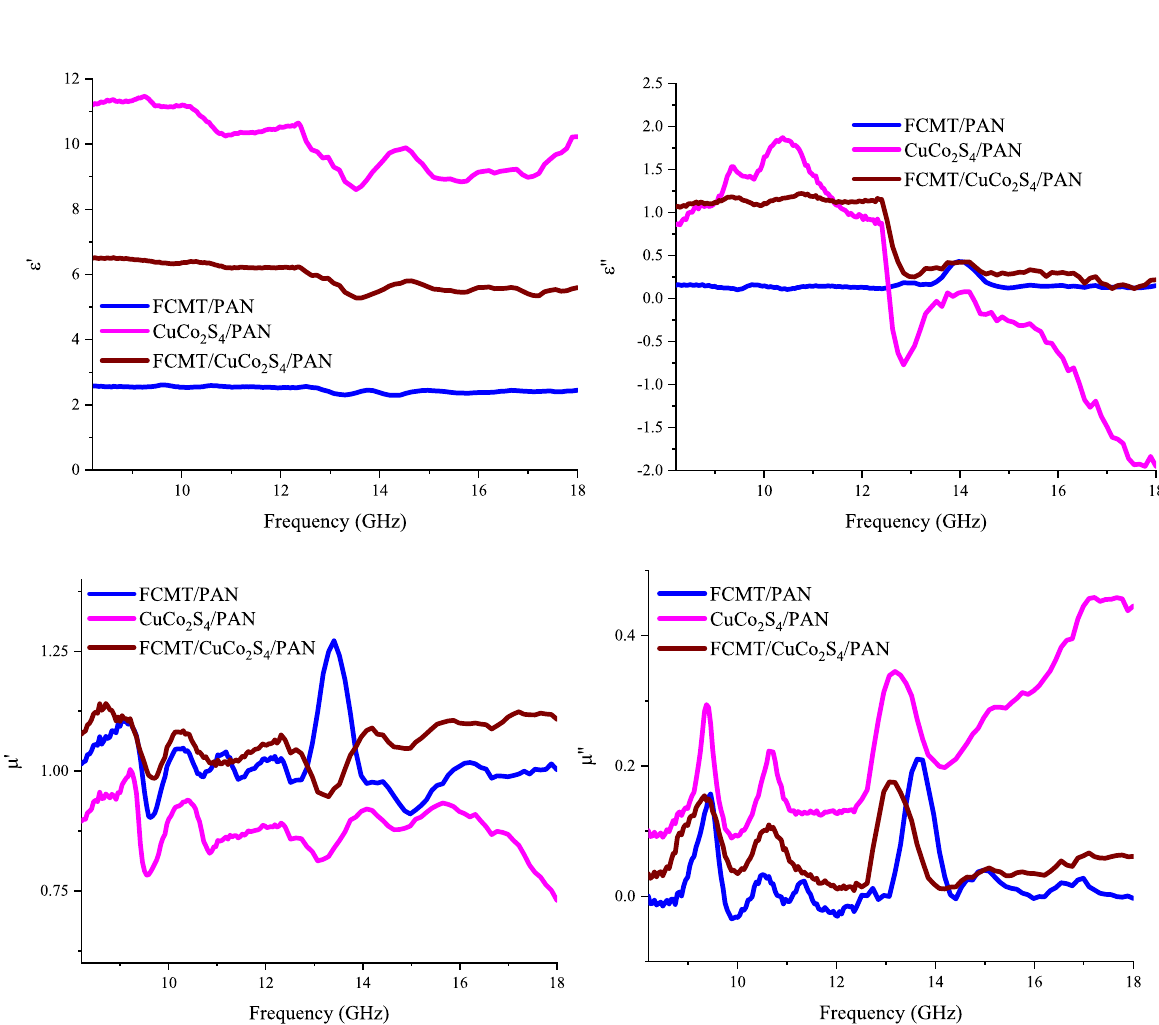
Figure 11. Relative complex permeability and permittivity of the absorbers from 8.2 to 18